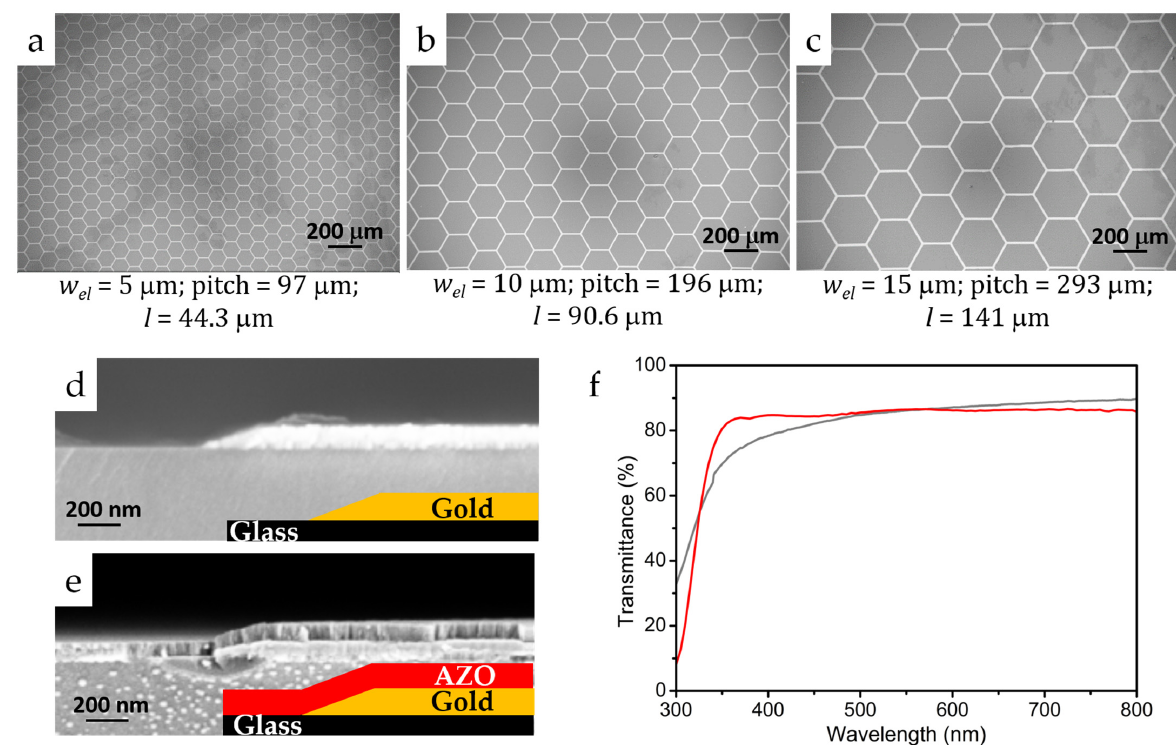
Figure 2. Scanning electron microscopy (SEM) images of Au-network electrodes with the pitch size of ( a ) 97 µ m, ( b ) 196 µ m and ( c ) 293 µ m deposited on glass substrates showing uniform honeycomb structures with well-defined geometry and dimensions over a large range; cross-sectional SEM images of ( d ) Au-network structure on a glass and ( e ) conformal covering of Au-network structure on glass by sputter-deposited aluminum-doped zinc oxide (AZO) layer and corresponding schemes as inset; ( f ) transmittance spectra of LT-TiO 2 (grey) and AZO (red)conducting filler layers deposited Au-network (pitch = 97 µ m) electrodes on glass